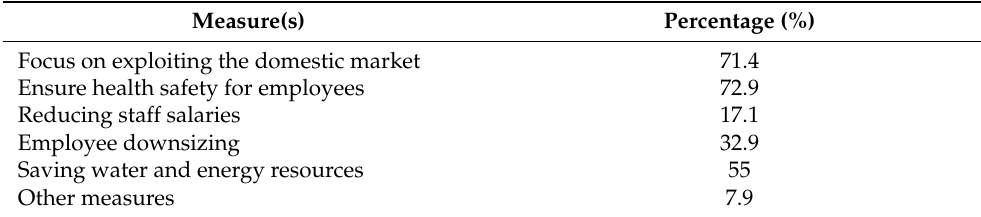
Table 3. Measures to minimize the negative impacts of the pandemic on tourism business activities of local enterprises (n = 280). Measure(s) Percentage (%) Focus on exploiting the domestic market 71.4 Ensure health safety for employees 72.9 Reducing staff salaries 17.1 Employee downsizing 32.9 Saving water and energy resources 55 Other measures 7.9 Source: Data from Huynh et al.